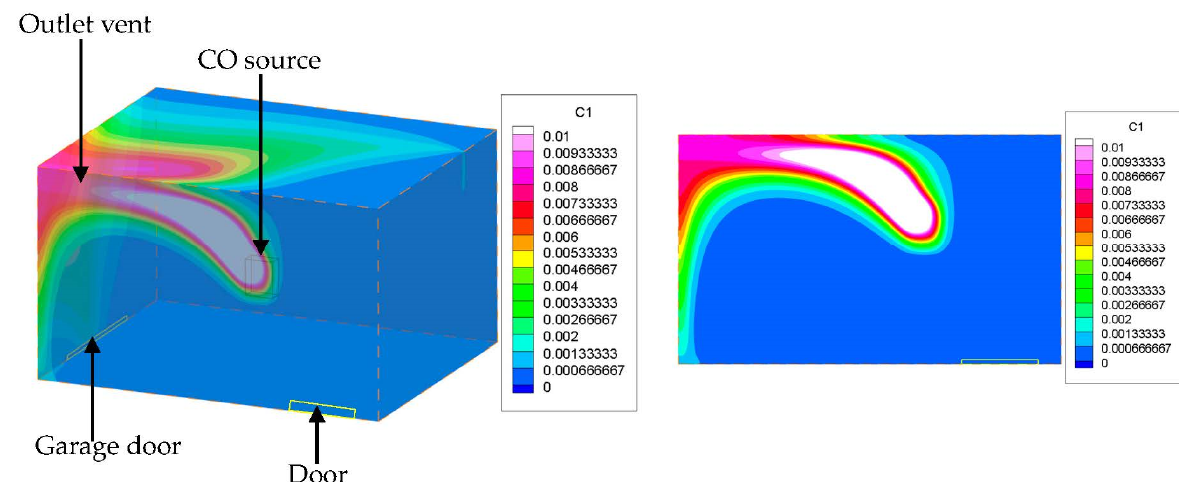
Figure 4. CO distribution in the garage—case 1 (concentration of CO in kg/kg).